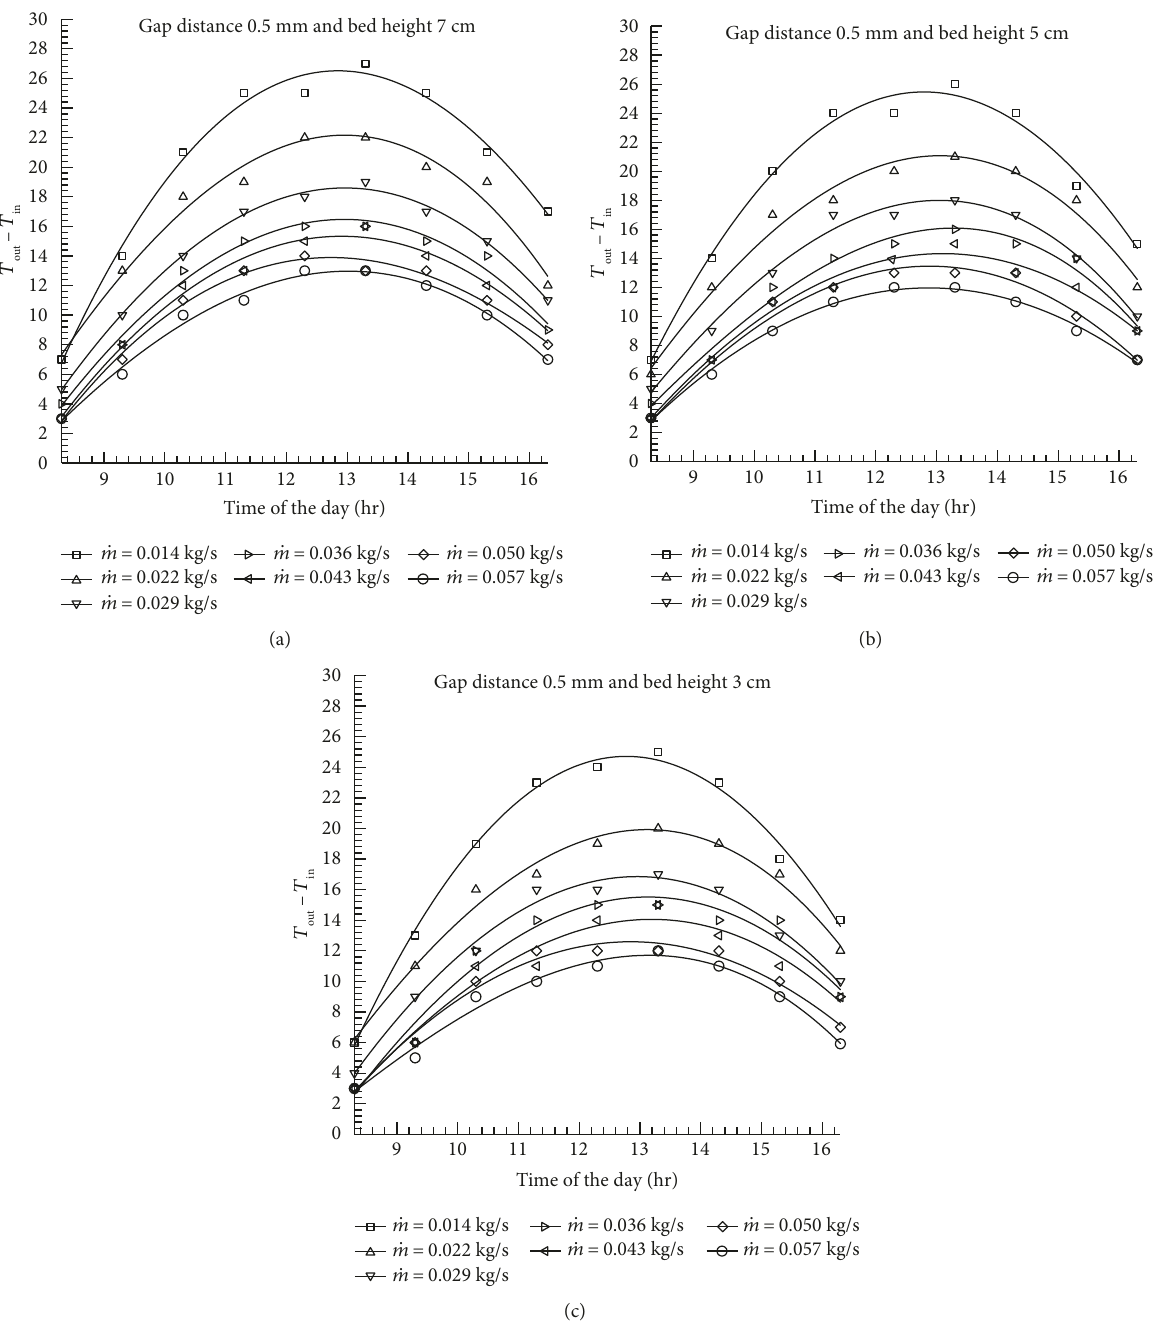
− T out in ) versus time at a gap distance of 0.5mm for di